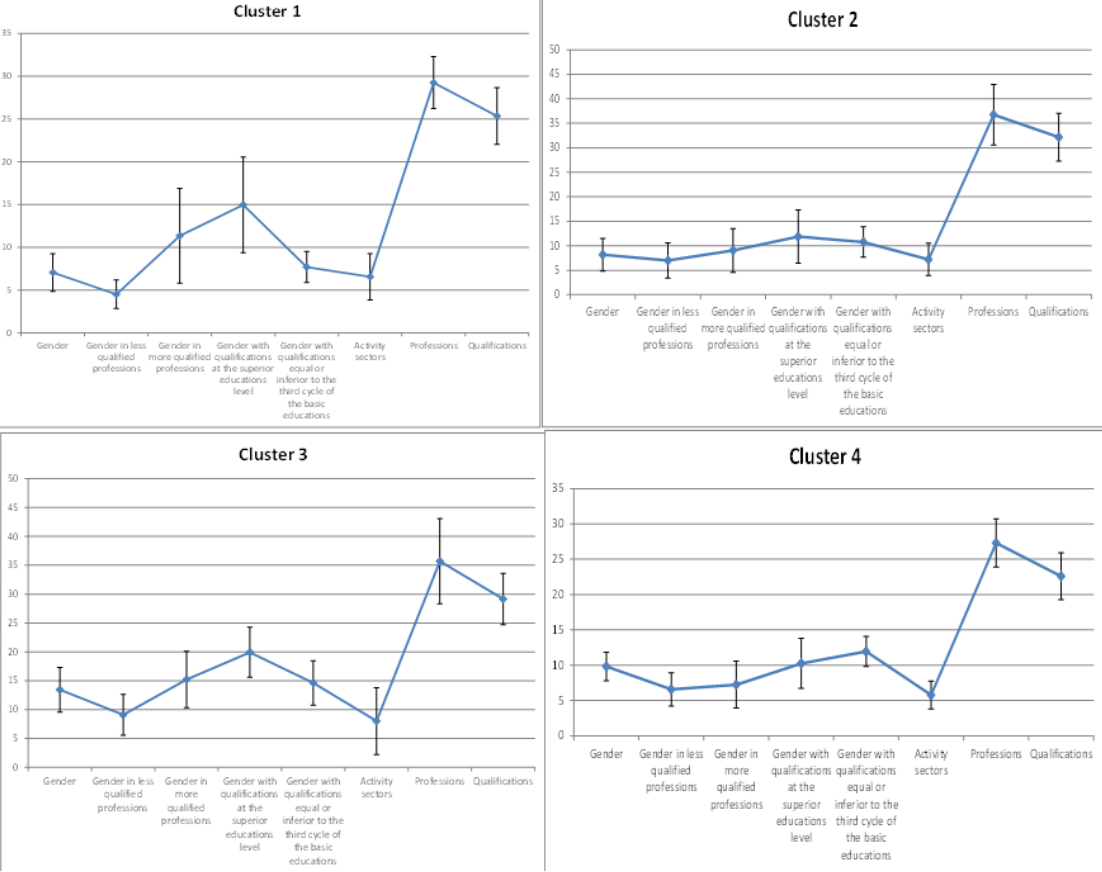
Figure 5. Disparities (averages % and standard deviations) in the monthly average earnings by employees and for all clusters.